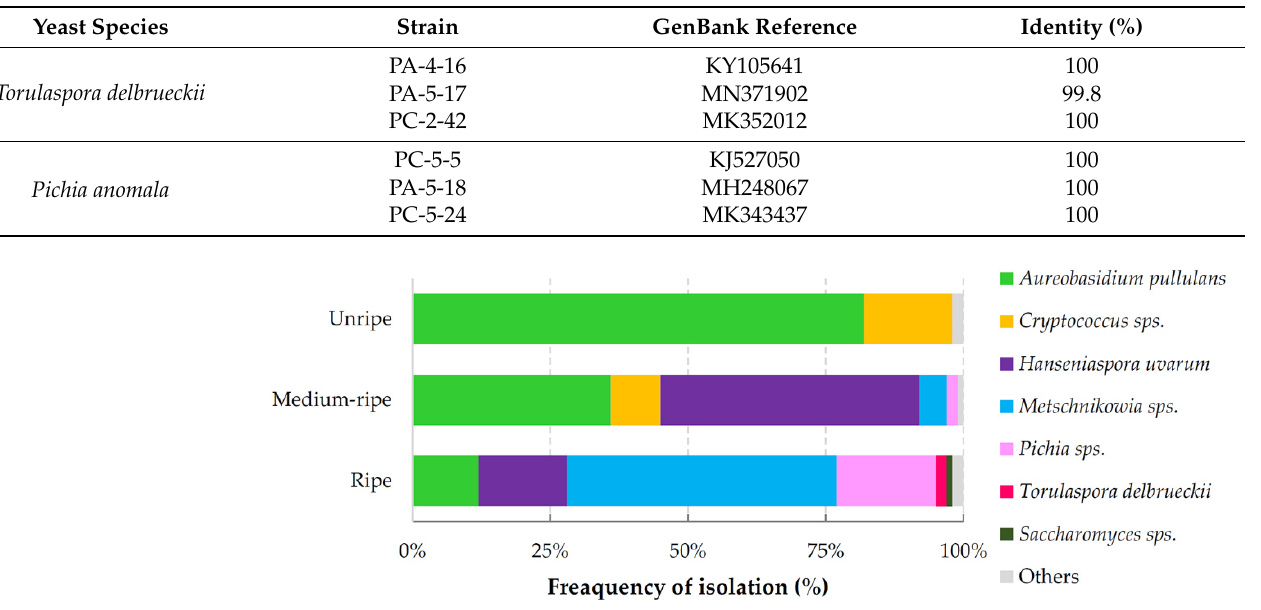
Figure A1. Frequency of yeast isolation among cherry samples at different ripening stages. C. wieringae dominated among Cryptococcus genus species; M. pulcherrima frequently occurred among Metschnikowia yeasts; Pichia genus were represented by P. anomala , P. kudriavzevii , P. kluyveri , P. fermentans , and P. membranifaciens yeasts; S. paradoxus occurred among Saccharomyces yeasts; others represented yeasts occurred in low frequency.